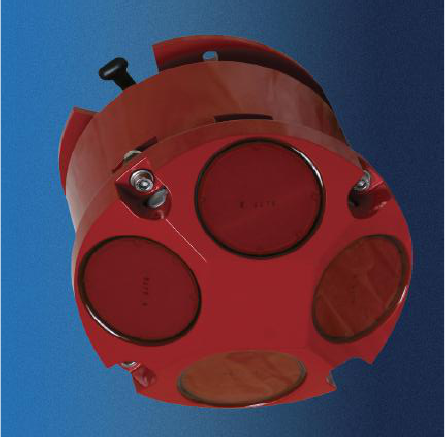
Figure 8. Workhorse navigator 1200K DVL.